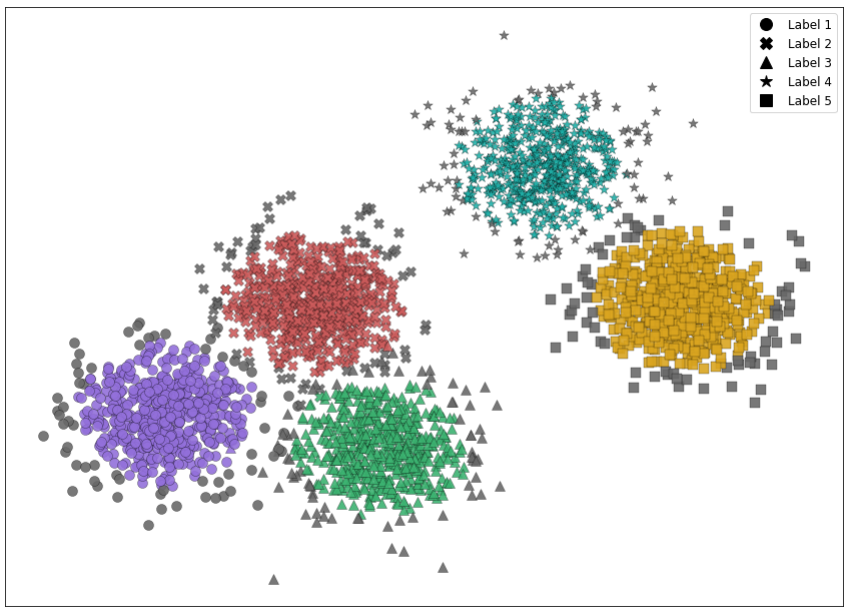
Figure 7. DBSCAN clustering of the synthetic data set with MDS dimension